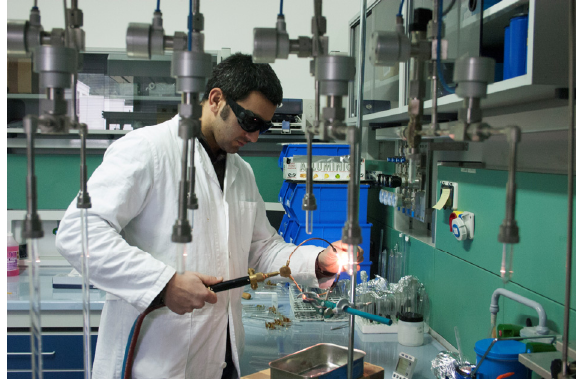
Figure 2. One of the stages of preparation of the wooden samples at CEDAD